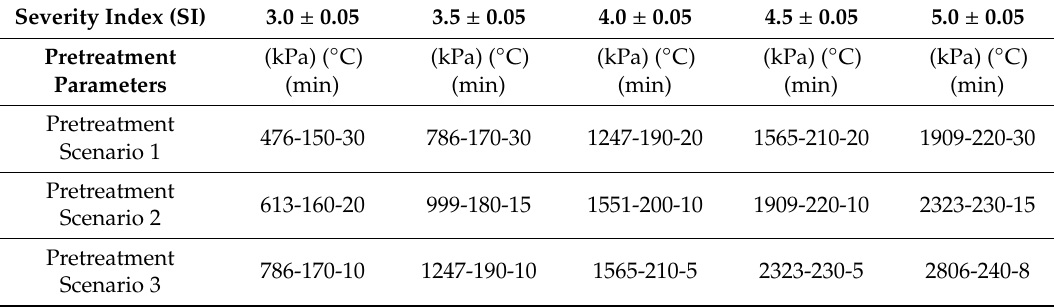
Table 3. Hydrothermal pretreatment (HTP) design of this